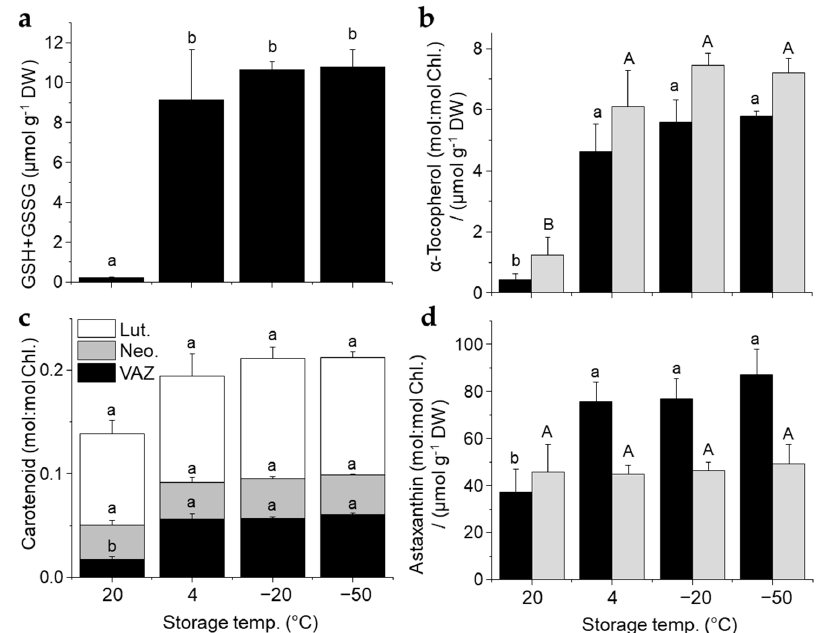
Figure 3. Effect of temperature on LMW antioxidant and pigment concentrations in cells equilibrated to 50% RH before storage in aluminum foil wraps for one year. Concentrations of ( a ) total glutathione, ( b ) α -tocopherol, ( c ) carotenoids, and ( d ) astaxanthin. Data in ( b , d ) is normalized on dry weight (DW) basis (black bars), and on the same scale, normalized to total chlorophyll (Chl., grey bars). Different lower case and capital letters denote significant differences ( p < 0.05) when normalized to DW and Chl., respectively, n = 3 ± SD. Lut. = lutein; Neo. Neoxanthin, VAZ = xanthophyll cycle